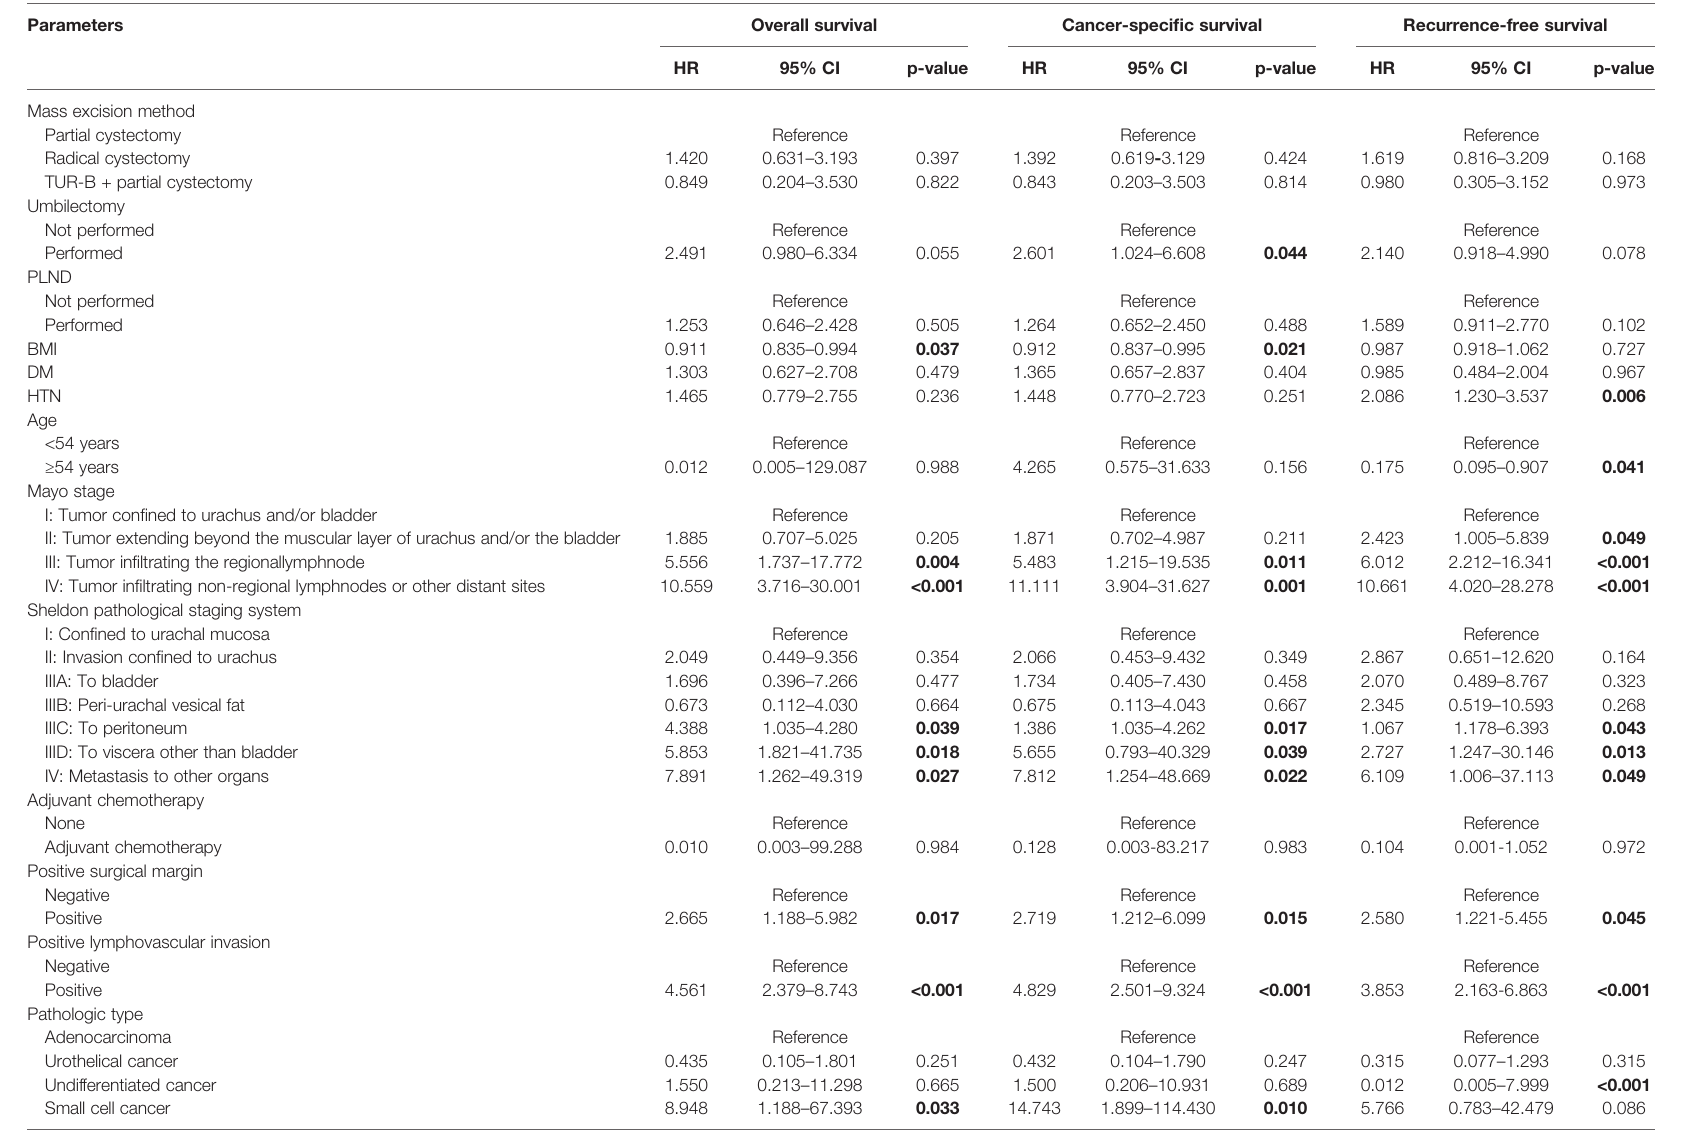
TABLE 3 | Predictors of survival